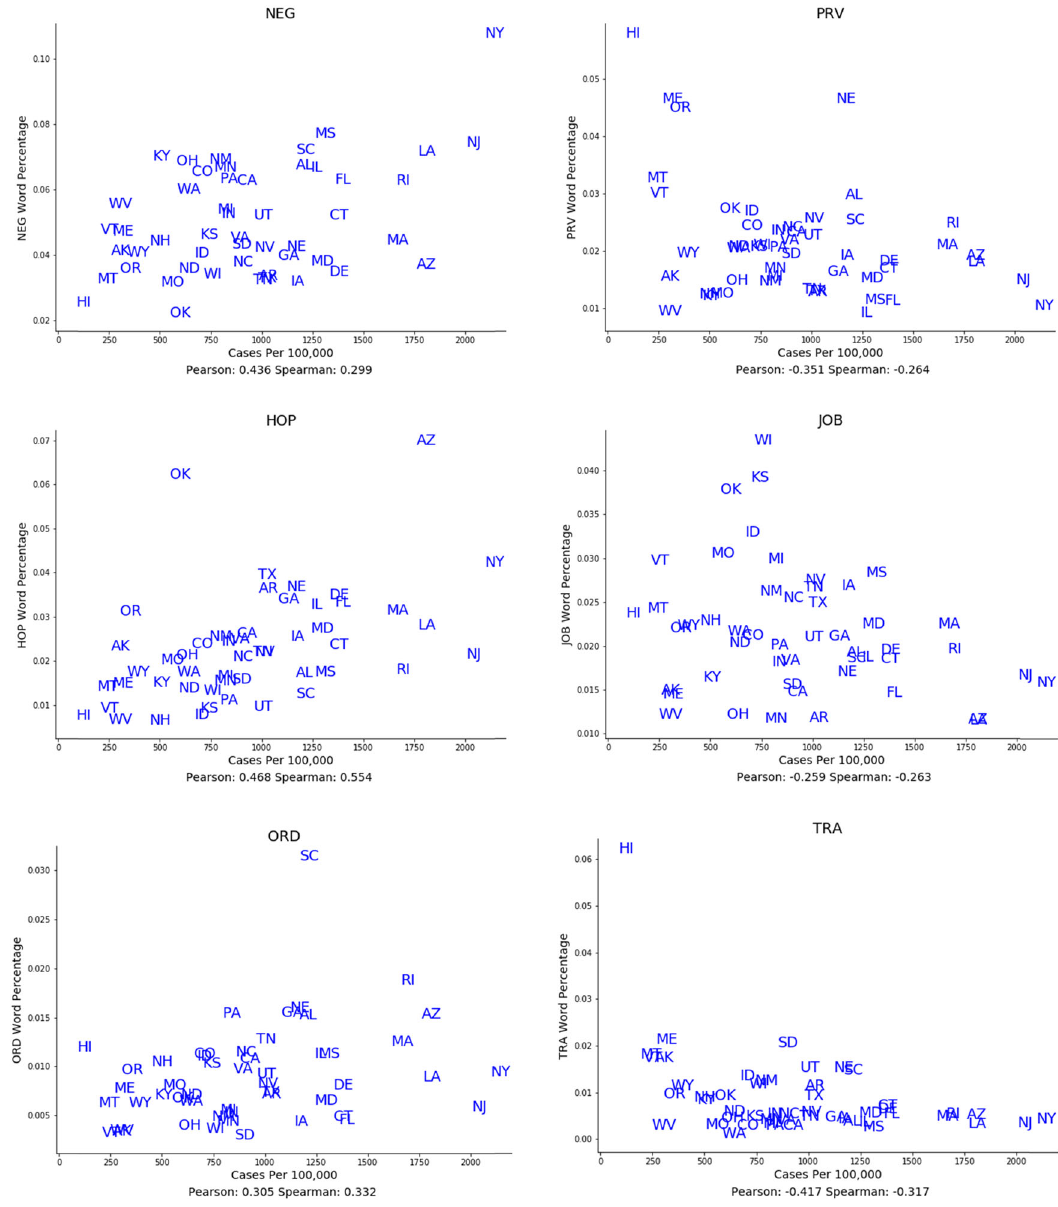
Fig. 2 Spatial associations of semantic categories with COVID-19 case rates. Both positive and negative associations are shown. States are represented by standard two-letter abbreviations. (NEG: Negation; JOB: Job-related; HOP: Hospital-related; PRV: Preventative measures; ORD: Strict instructions; TRA: